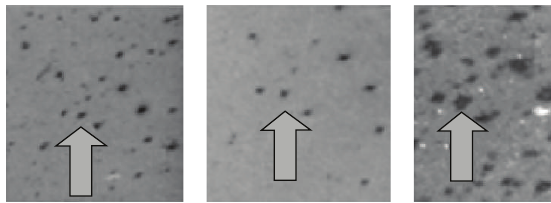
Figure 4: IGR J10109-5746, hard X-ray symbiotic star. Optical variability on Franklin Adams plates, field 10, Leiden, year 1928.